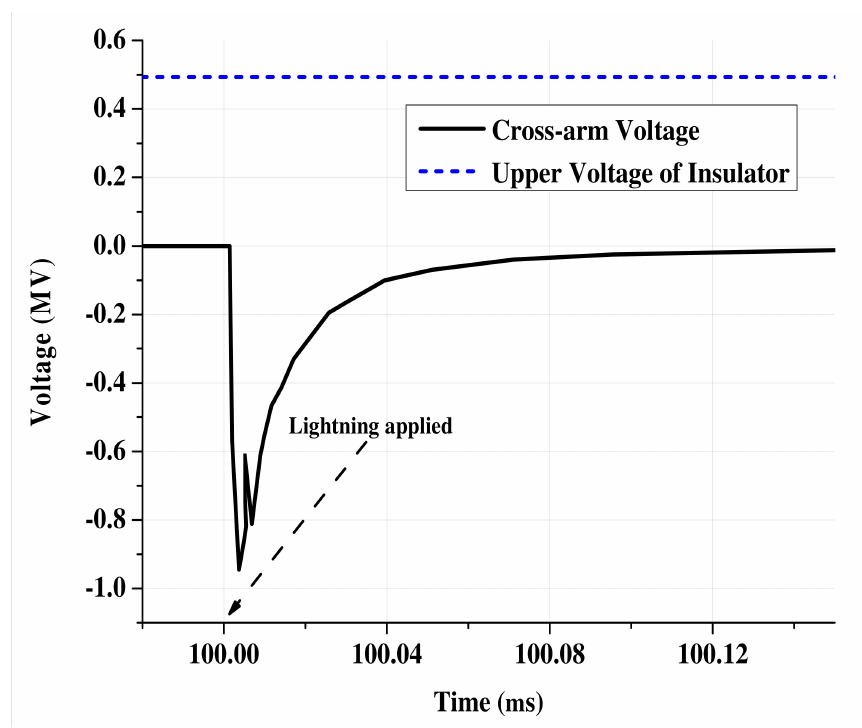
Figure 18. Voltage at tower cross-arm point and upper point of insulator at 28 kA and 50 Ω groun- ding